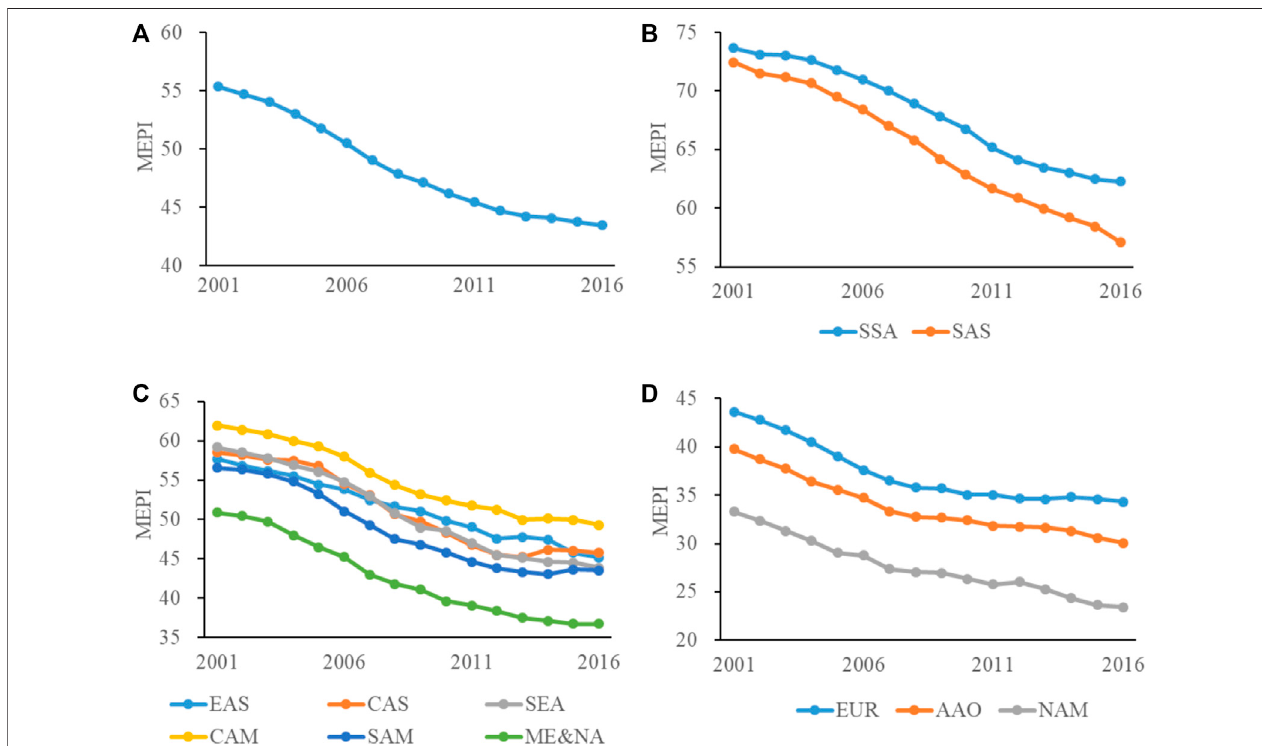
FIGURE 1 | Change in the MEAI from 2001 to 2016. (A) At the global level. (B – D) At the regional level. North America is the abbreviation for NAM, Central America for CAM, South America for SAM, Middle East and North Africa for ME&NA, sub-Saharan Africa for SSA, Europe for EUR, Central Asia for CAS, East Asia for EAS, Southeast Asia for SEA, South Asia for SAS, and Australia and Oceania for